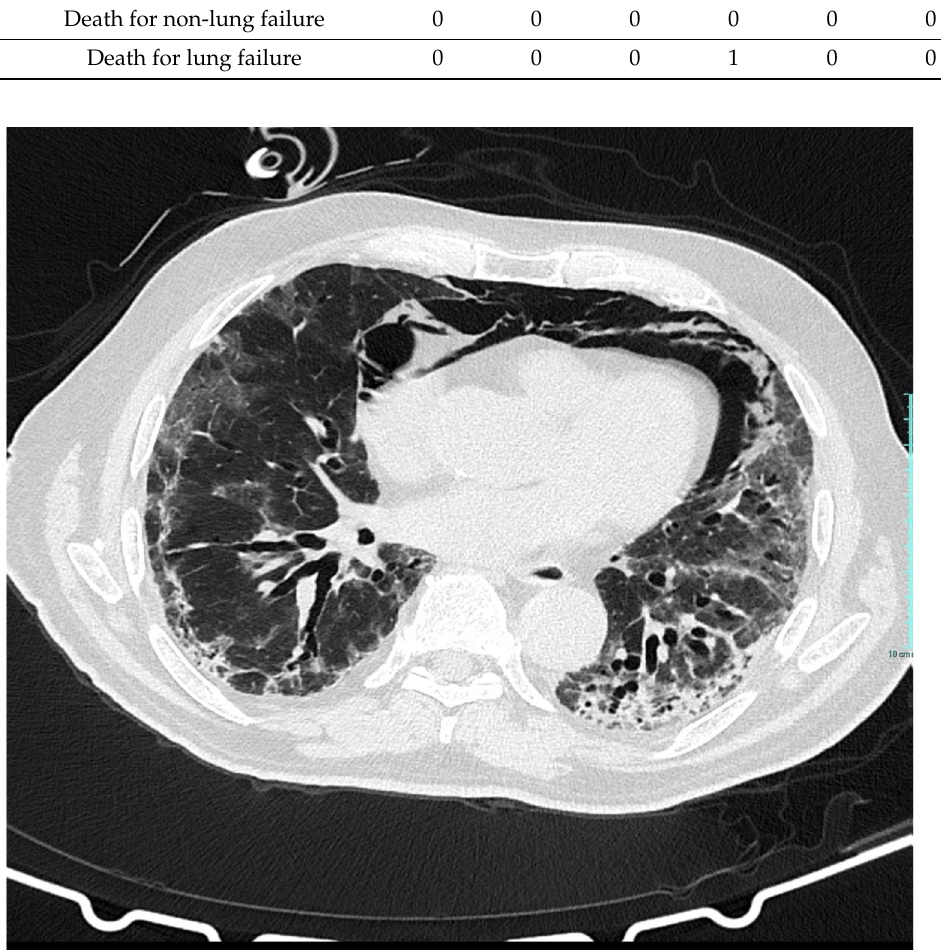
Figure 3. Coronal CT image shows multiple mixed ground-glass opacities in both lungs and pneumomediastinum.